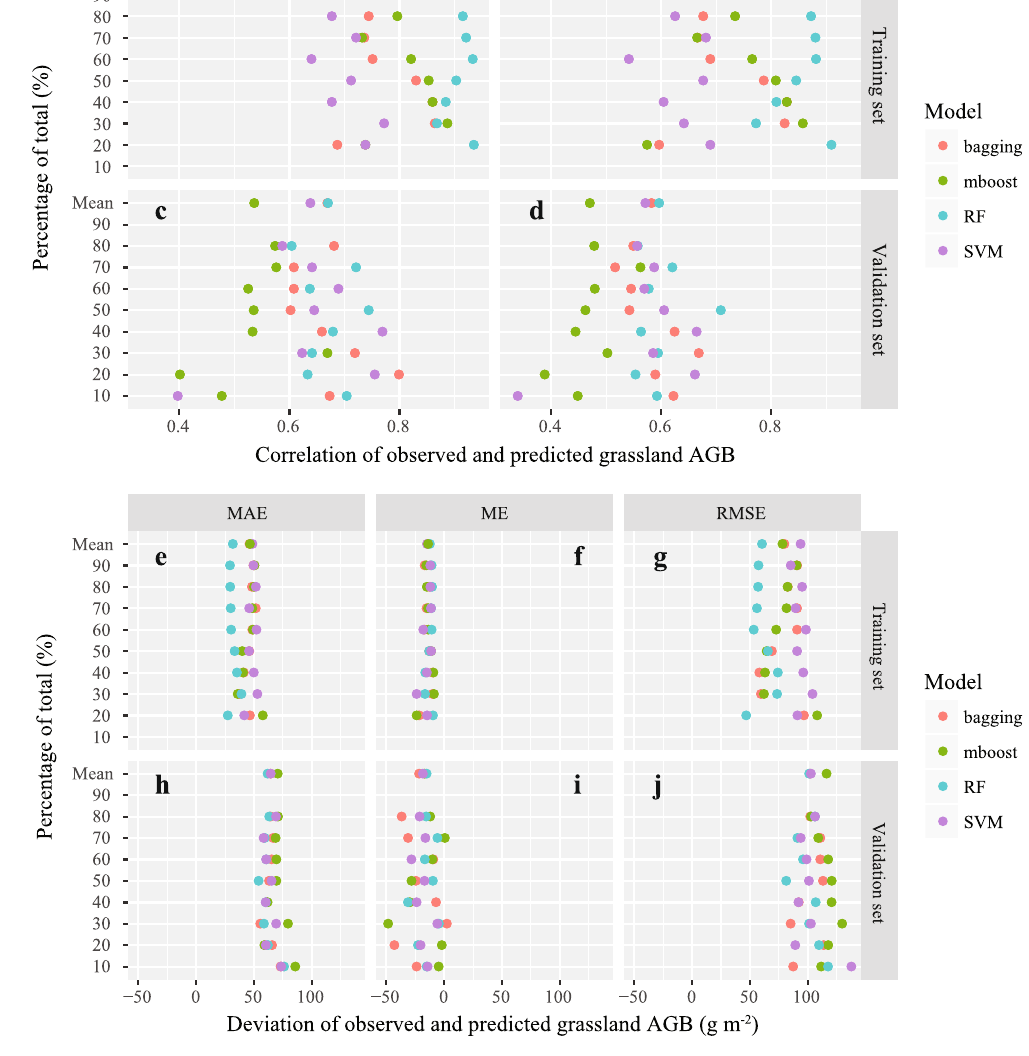
Figure 3. RF model validation and comparison with other machine learning